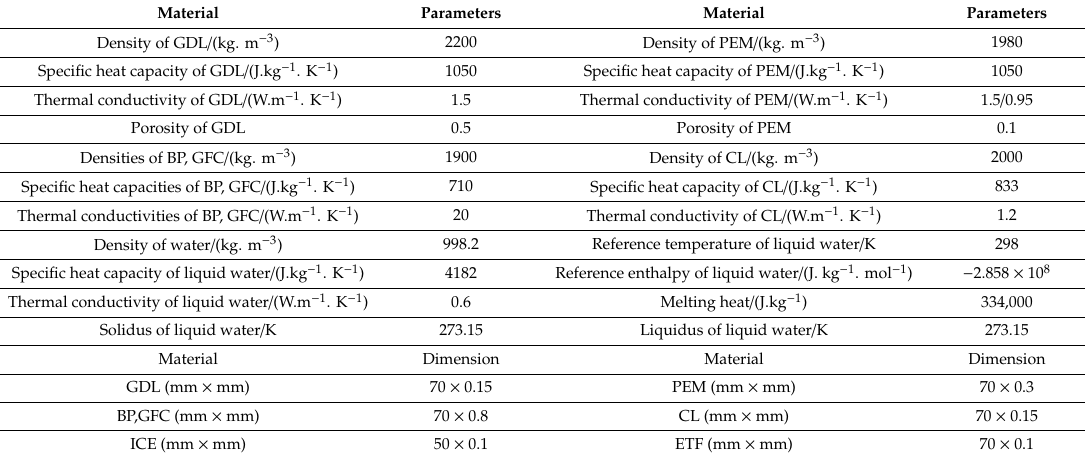
Table 1. The structure dimensions and material parameters [34].